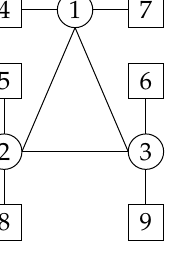
Figure 2. Information topology of the spacecraft formation system. Table 1. Desired orbital parameters.